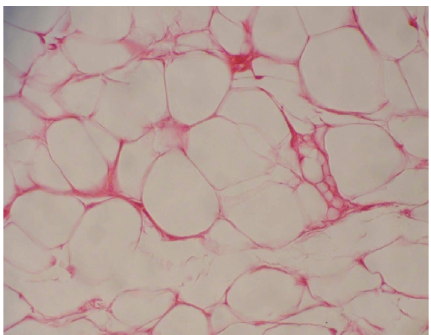
Figure 3: Photomicrograph. Well-di ff erentiated liposarcomas com- posed of fat cells of a variety of sizes and shapes. H and E stain ( ×